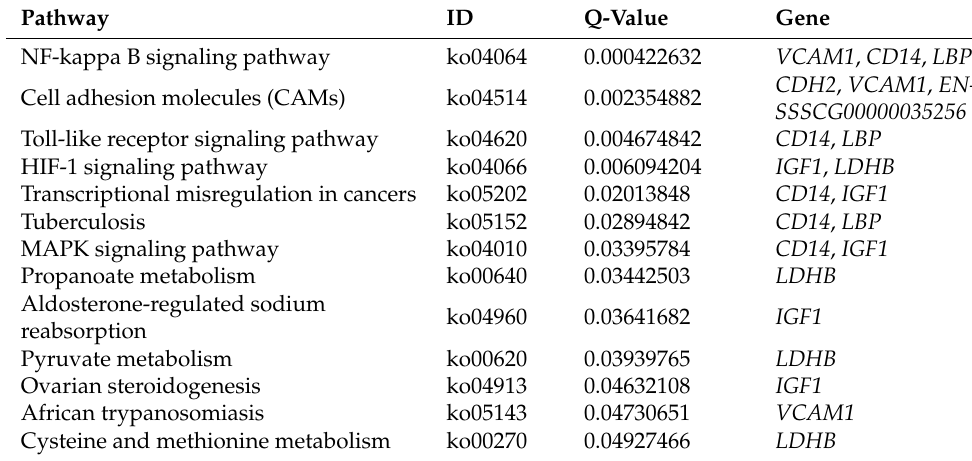
Figure 5. Expression concordance of proteotranscriptomic results for blood serum between M and LW pigs. ( A ) Venn diagram of gene sets of mRNA–protein pairs, DE mRNAs, and DE proteins. ( B , C ) Heatmaps of expression of 16 overlapping mRNAs. Table 1. KOBAS pathway enrichment